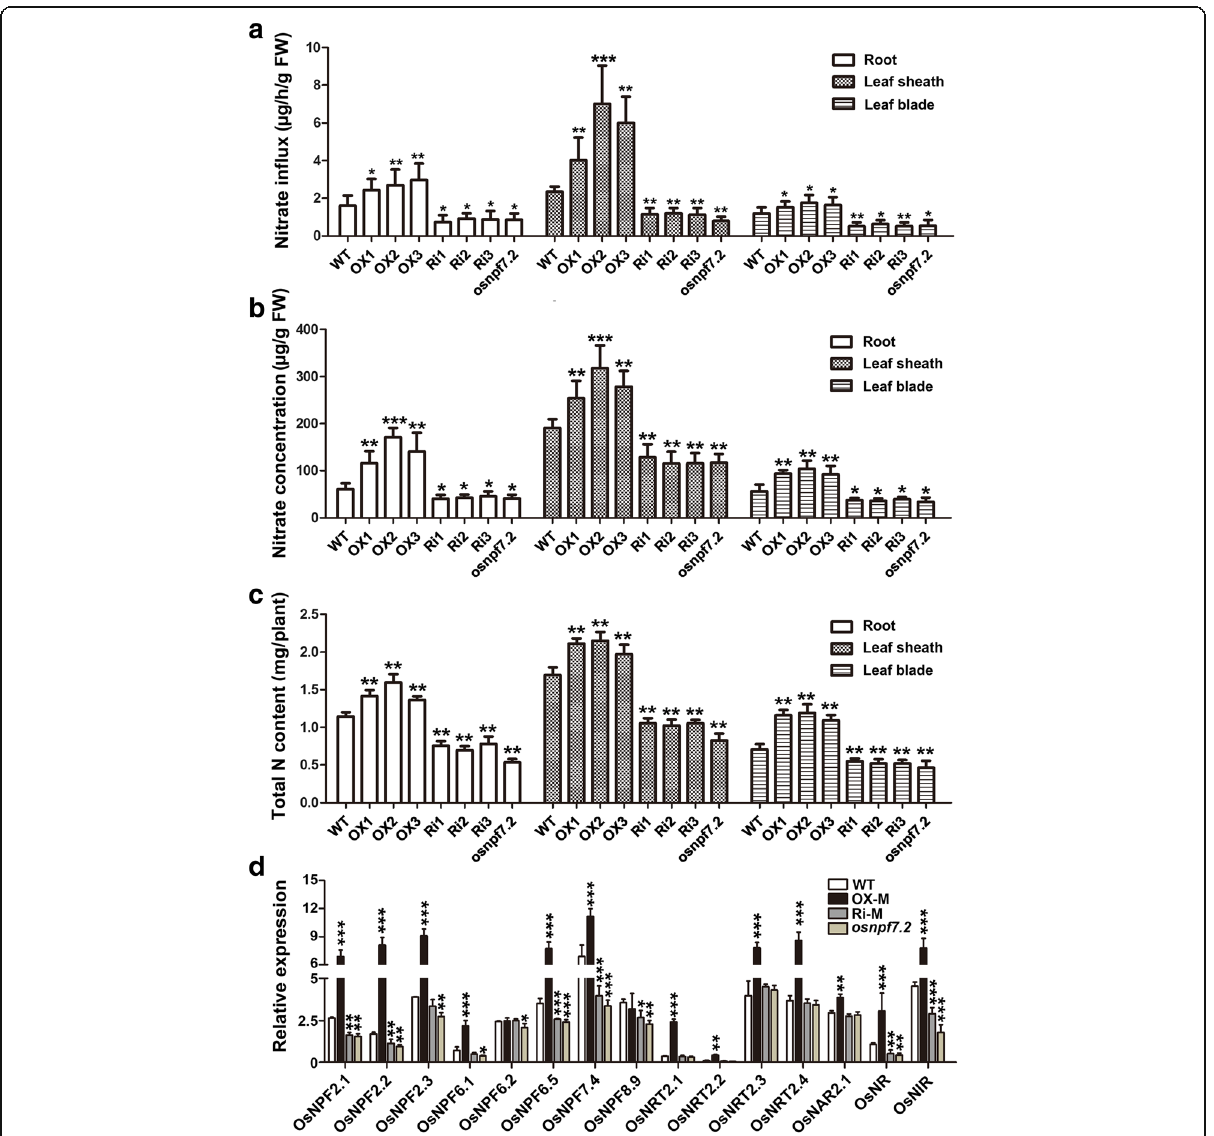
among WT, OX lines, Ri lines and osnpf7.2 cultured under 6 mM NaNO 3 supply. b NO 3 − concentration of WT, OX lines, Ri lines and osnpf7.2 cultured under 6 mM NaNO 3 supply. c Comparison of total nitrogen content among WT, OX lines, Ri lines and osnpf7.2 cultured under 6 mM NaNO 3 supply. d Expression level of crucial genes involved in absorbing, transporting and assimilation of nitrate among WT, OX-M, Ri-M and osnpf7.2 cultured under 6 mM NaNO 3 supply. OX-M and Ri-M indicated that mixed equal-amount RNA which extracted from 10 seedlings buds of each three OX lines and Ri lines, respectively. Date are shown as mean ± SD (n = 10) from three replicates; “ * ” , “ ** ” and “ *** ” indicated sig- nificant differences at P < 0.05, P < 0.01 and P < 0.001,